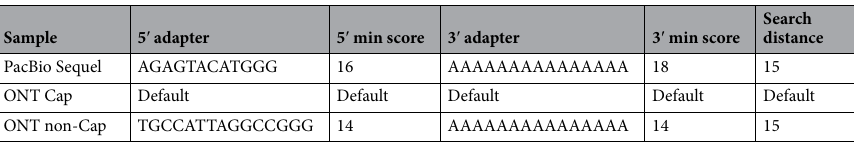
Table 5. Settings of the LoRTIA software suite for each sample